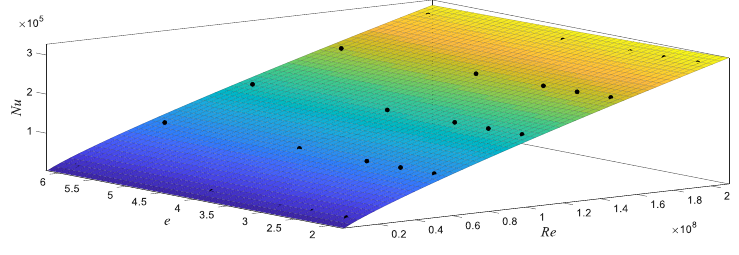
Figure 6. Fitting points and fitting surface.